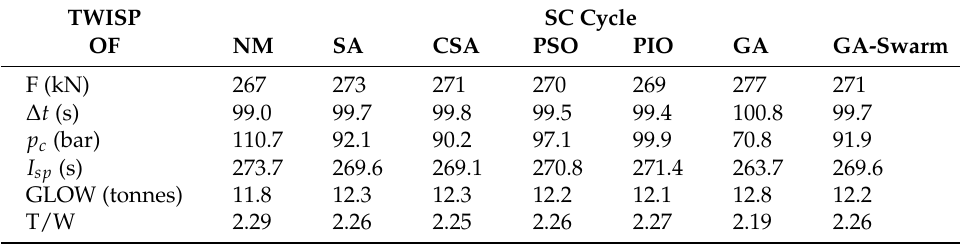
Figure 7. SC Cycle: T/W vs I sp for all techniques. Table 11. SC Cycle: Values of Variables at max I sp and T/W for each